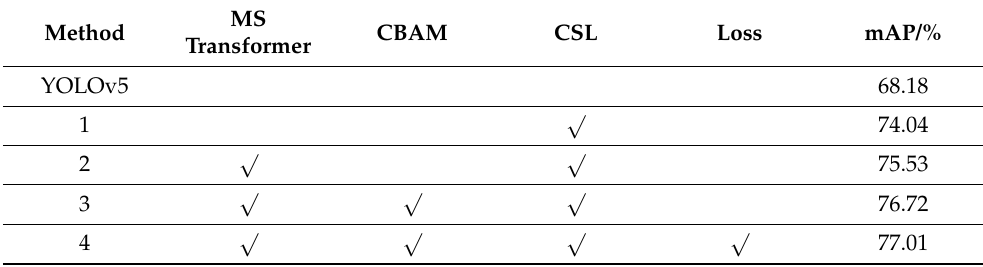
Table 2. Experimental comparisons of each combination in the feature extraction